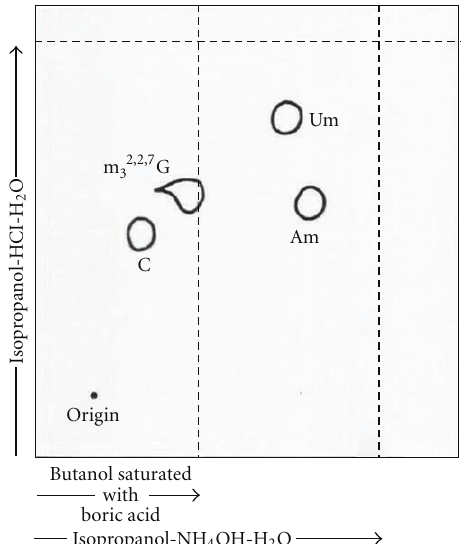
Figure 25: Two-dimensional chromatography in borate system [12]. The nucleoside mixture from U2 RNA 5 (cid:2) oligonucleotide (RNase A product) was obtained by digestion with snake venom phosphodiesterase and alkaline phosphatase. The resulting nucleosides were separated with the borate system. Um and Am migrated through the butanol-boric acid while the m 32,2,7 G and C, which form borate complexes, were retained in the butanol-boric acid